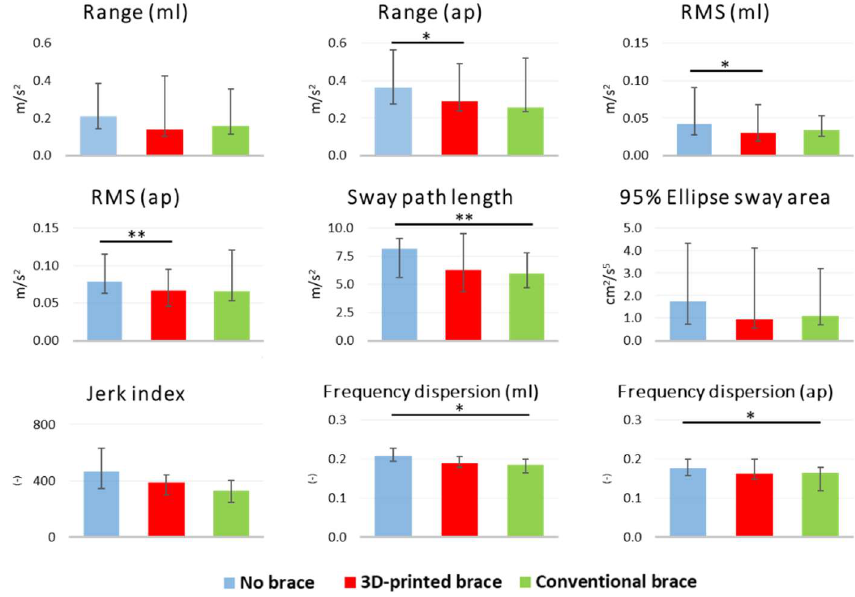
Figure 6. Postural stability results. Significance codes: ‘**’ 0.01; ‘*’ 0.05.